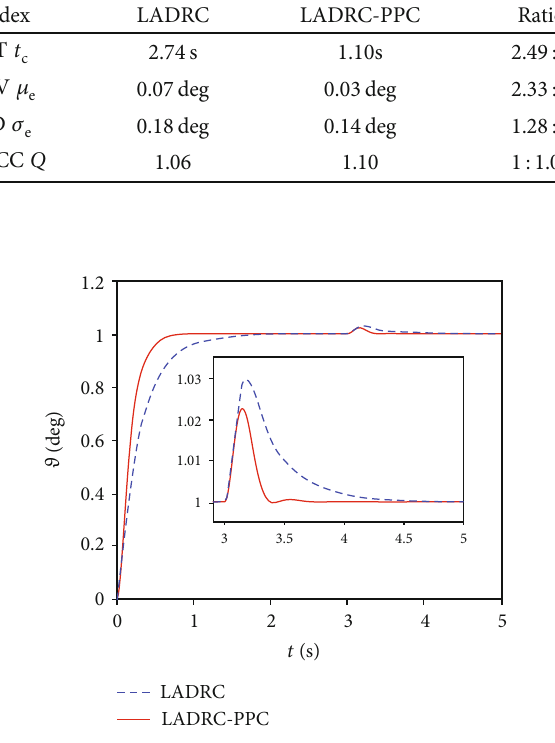
Figure 11: Pitch angle.